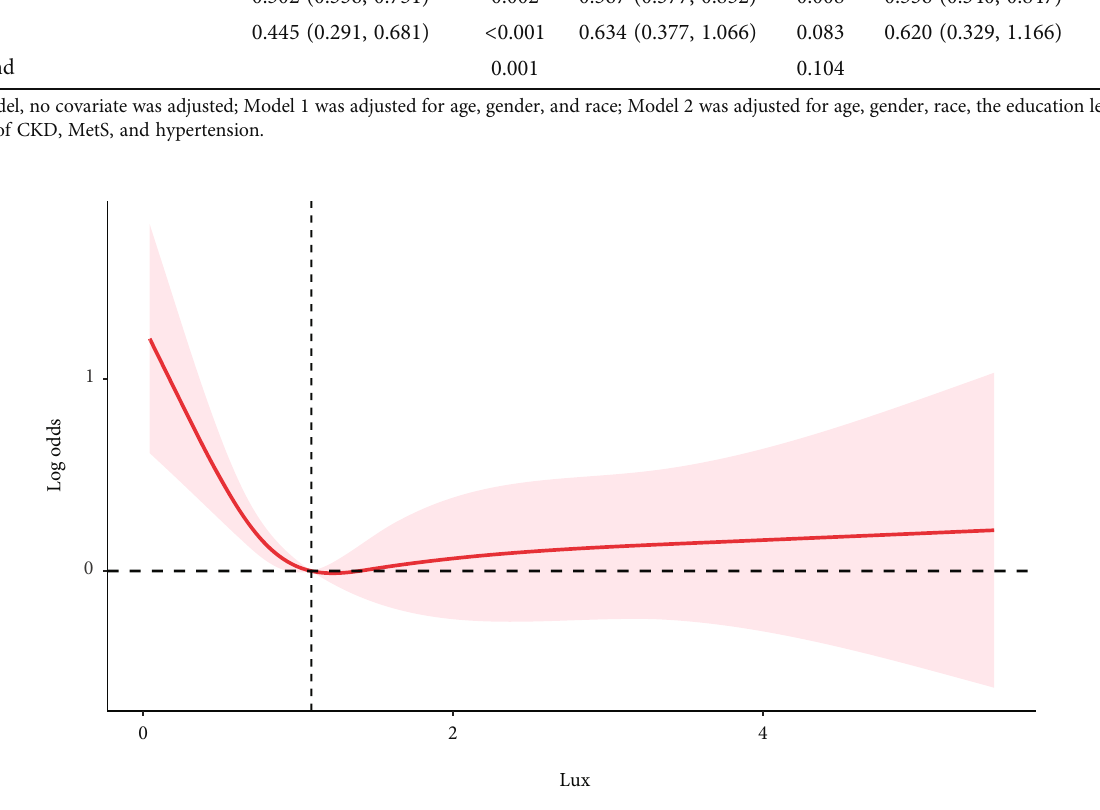
Figure 2: Association between AI and cognitive impairment. Age, gender, race, the education level, and diagnosis of CKD, MetS, and hypertension were adjusted ( P for nonlinearity: Table 3: Estimation of change-points in the association between AI and cognitive impairment.